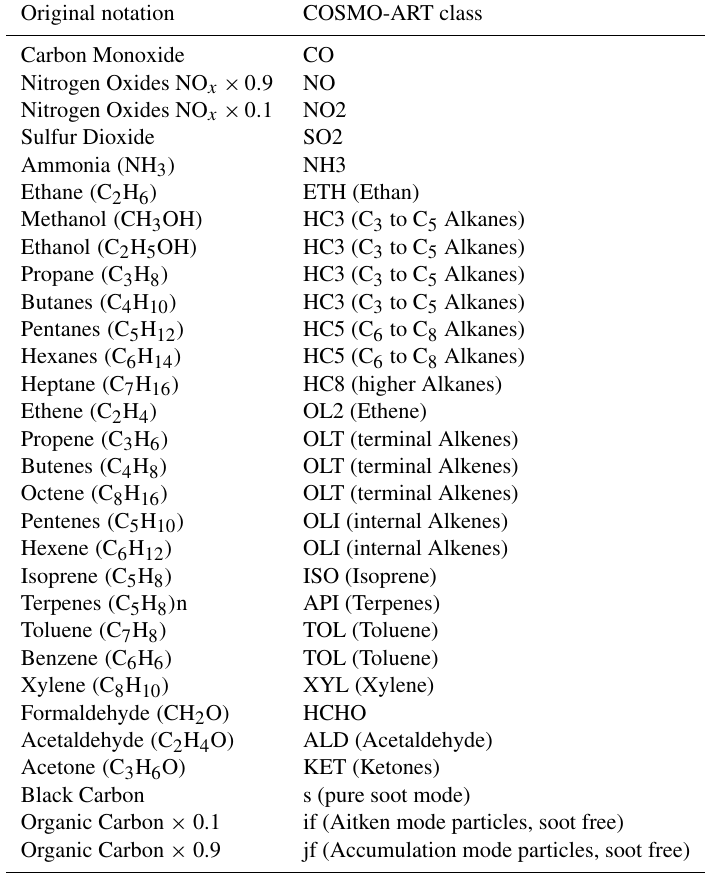
Table 2. Emitted gaseous and particulate species derived from